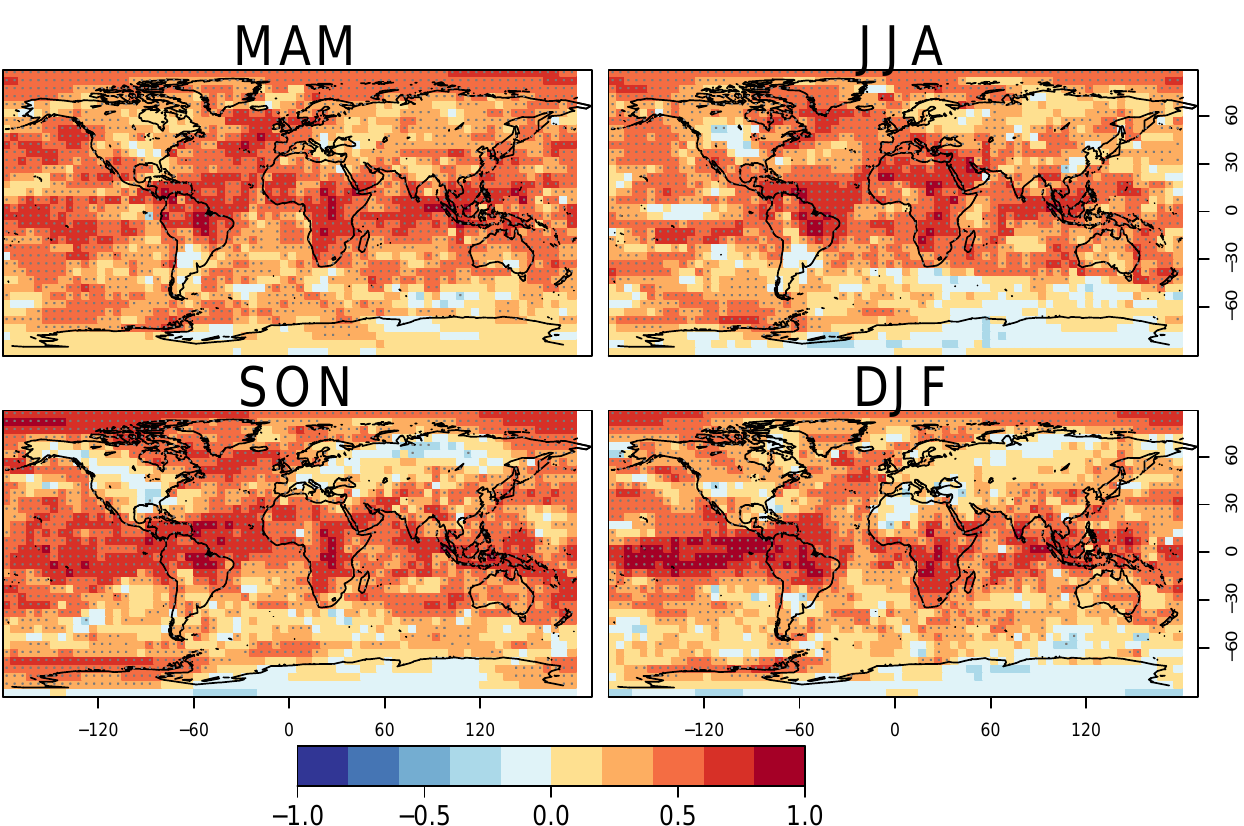
Figure 4. Correlation between observations and SAT hindcasts generated using the regression model with all predictors (1961–2013). Stip- pling is used to indicate significance at the 95%